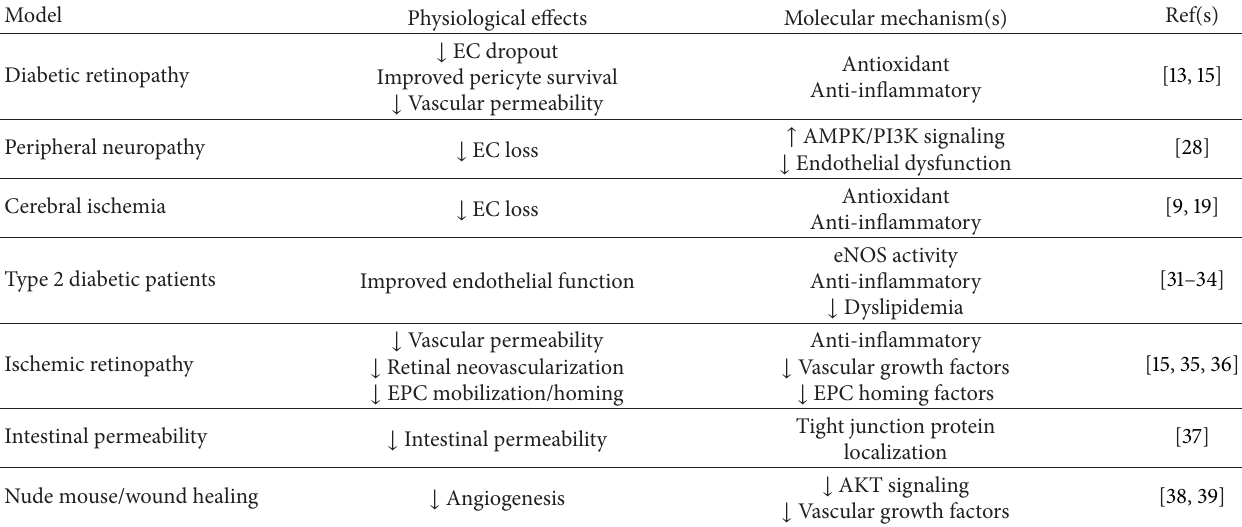
Table 2: Beneficial effects of PPAR 𝛼 in microvascular disease and molecular mechanisms of